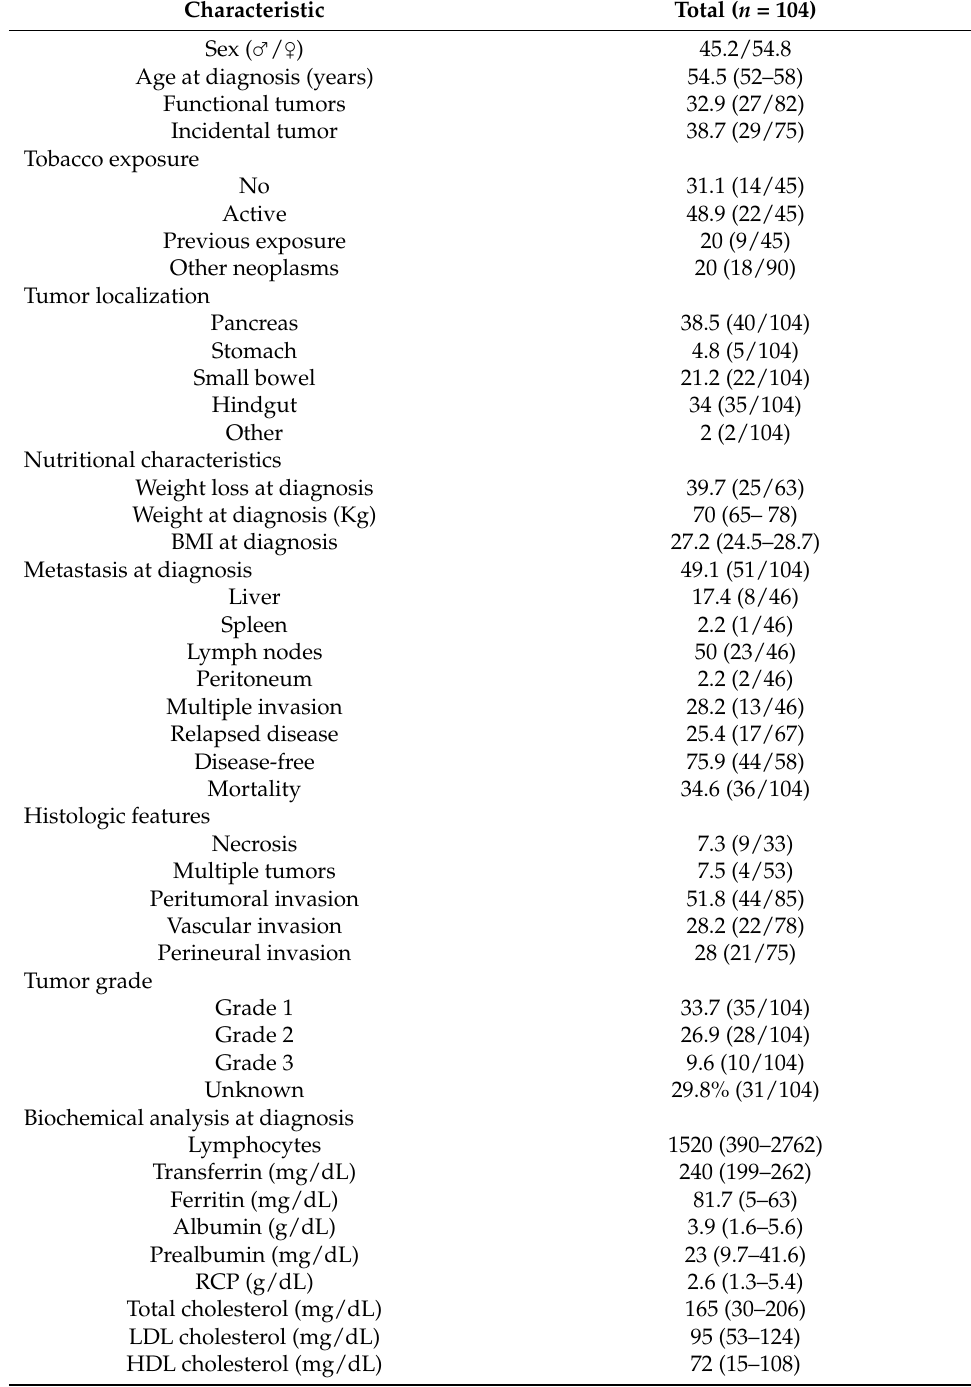
Table 1. Baseline clinical and biochemical